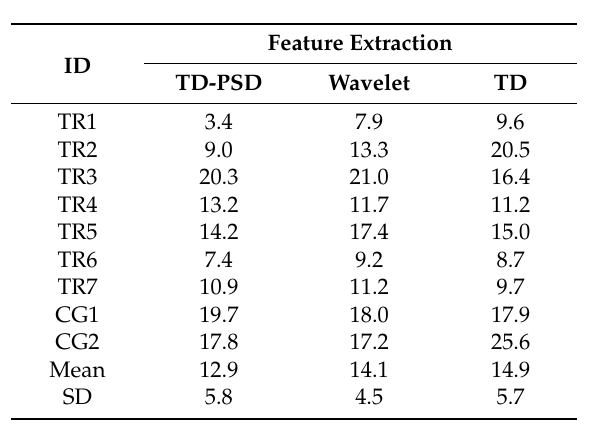
Table 3. Error rates for the proposed adaptive windowing framework (9 movements with 7 EMG channels) for all nine amputees, with 3 feature extraction methods, (a) Time Domain Power